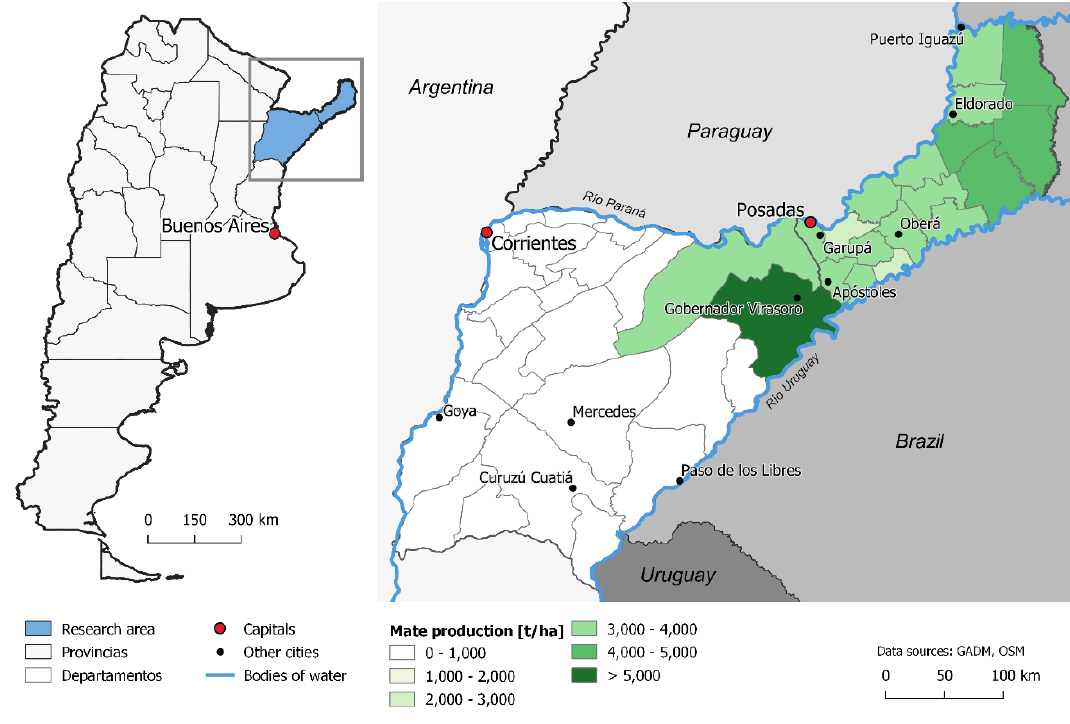
Figure 1 . Research area. The departments where yerba mate is cultivated are colour-coded based on production in